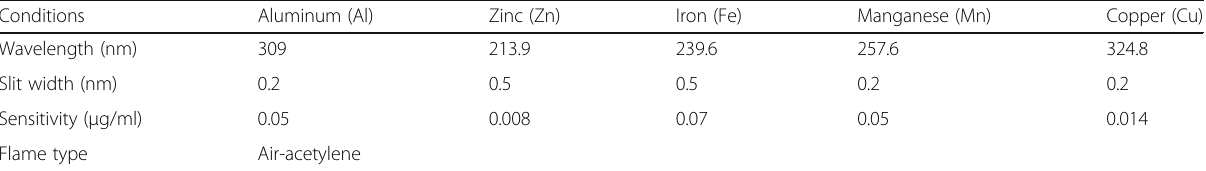
Table 2 Flame atomic absorption spectrophotometer (FAAS) operating method conditions